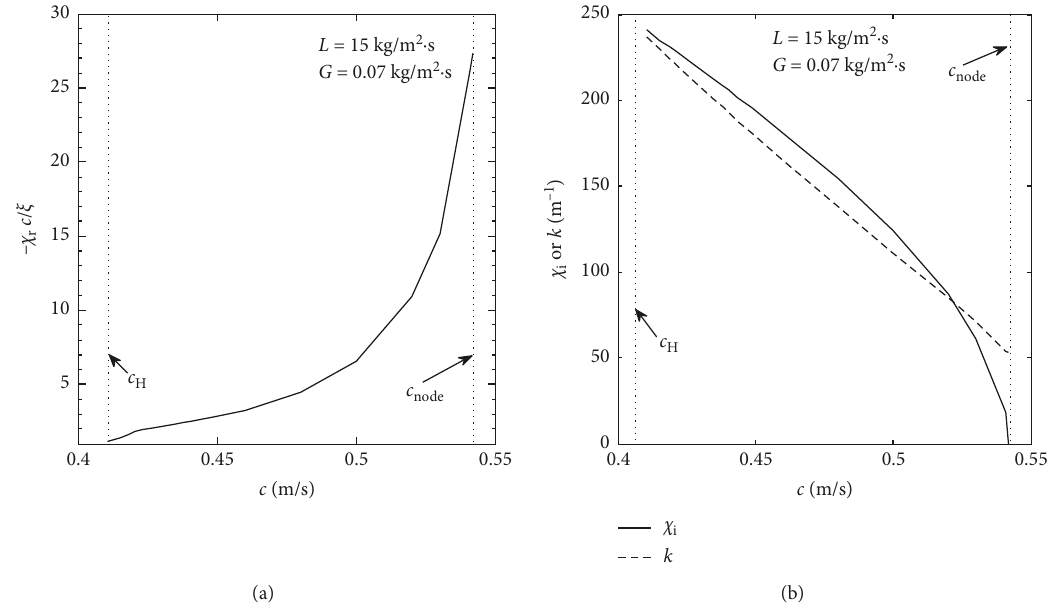
Figure 3: (a) Real part of the eigenvalue of the ε 0 base uniform flow in the full model, for the same system as in Figure 2(b). (b) Imaginary part of the eigenvalue of the ε 0 k 0 path as a function of the wavenumber with phase velocity c for the base uniform flow in the full model, for the same system as in l Figure